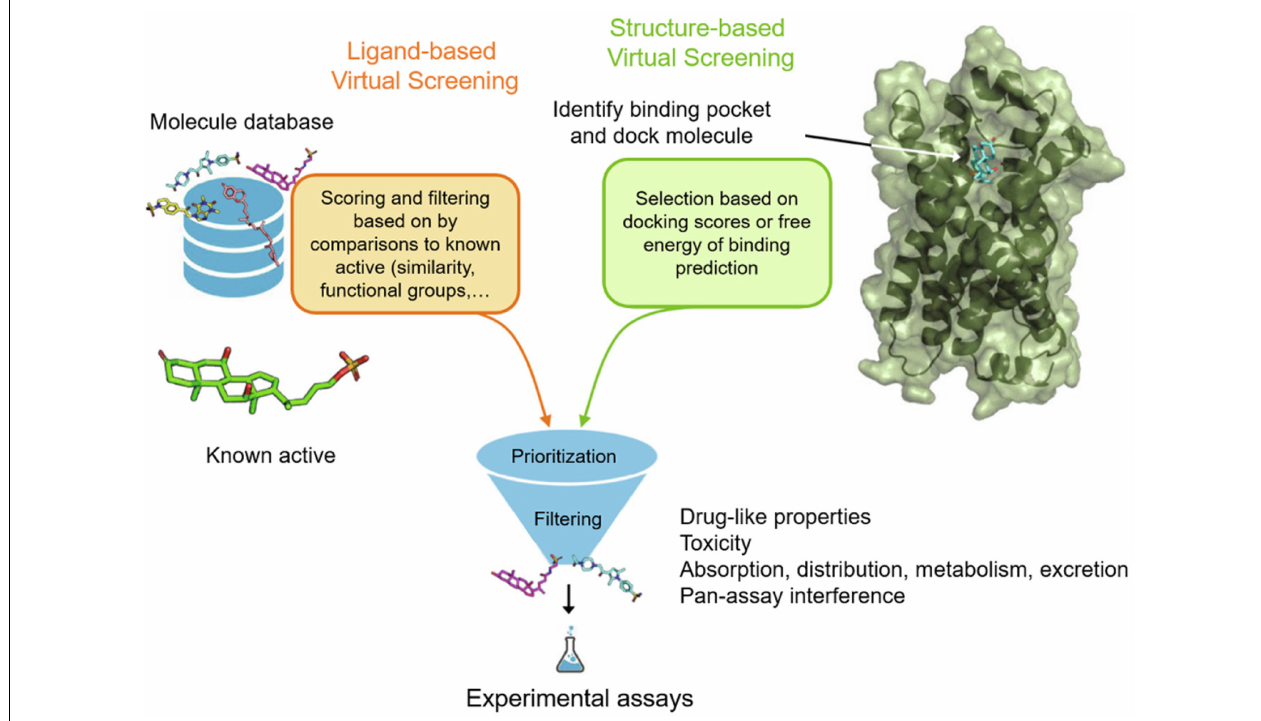
FIGURE 2 | Workflow for ubiquitination regulator discovery by ligand-based virtual screening (LBVS) and structure-based virtual screening (SBVS). Reproduced, with permission, from Reference Raschka and Kaufman